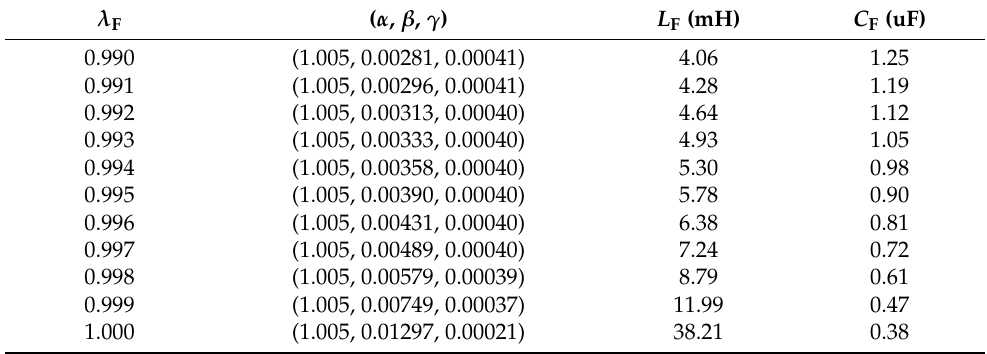
Table 3. The corresponding L F and C F when input fundamental power factor changes.